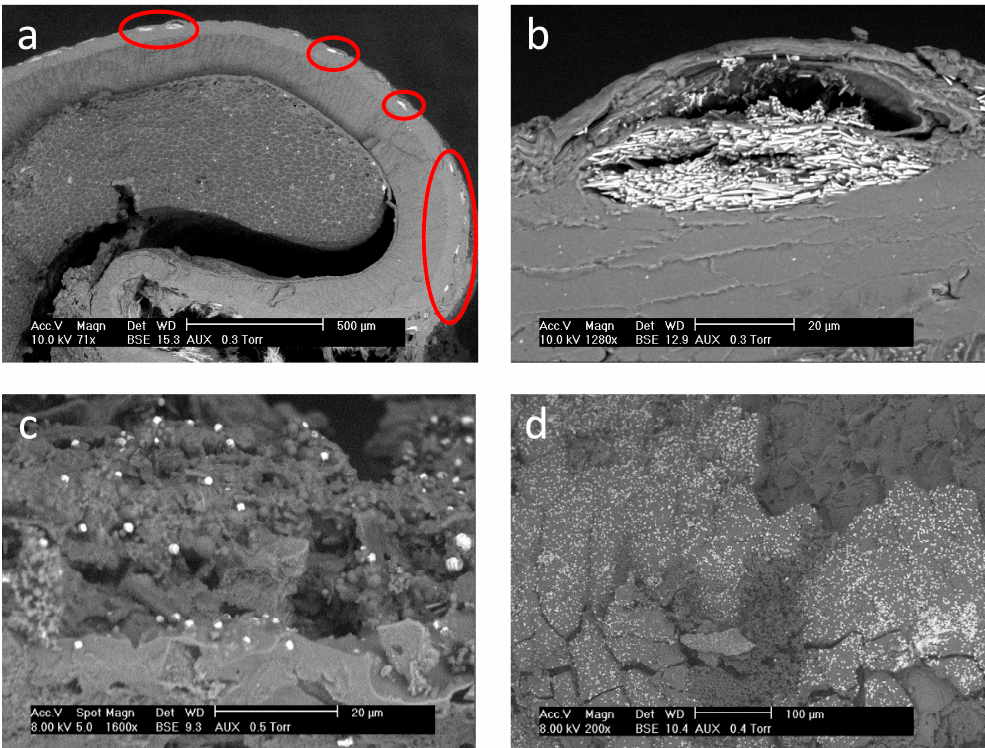
Figure 1. SEM images of grape seeds ( a , b ), carbonized grape skins ( c ) and carbonized grape seeds ( d ). Both grape skins and seeds ( c , d ) were carbonized at 250 °C for 8 h.